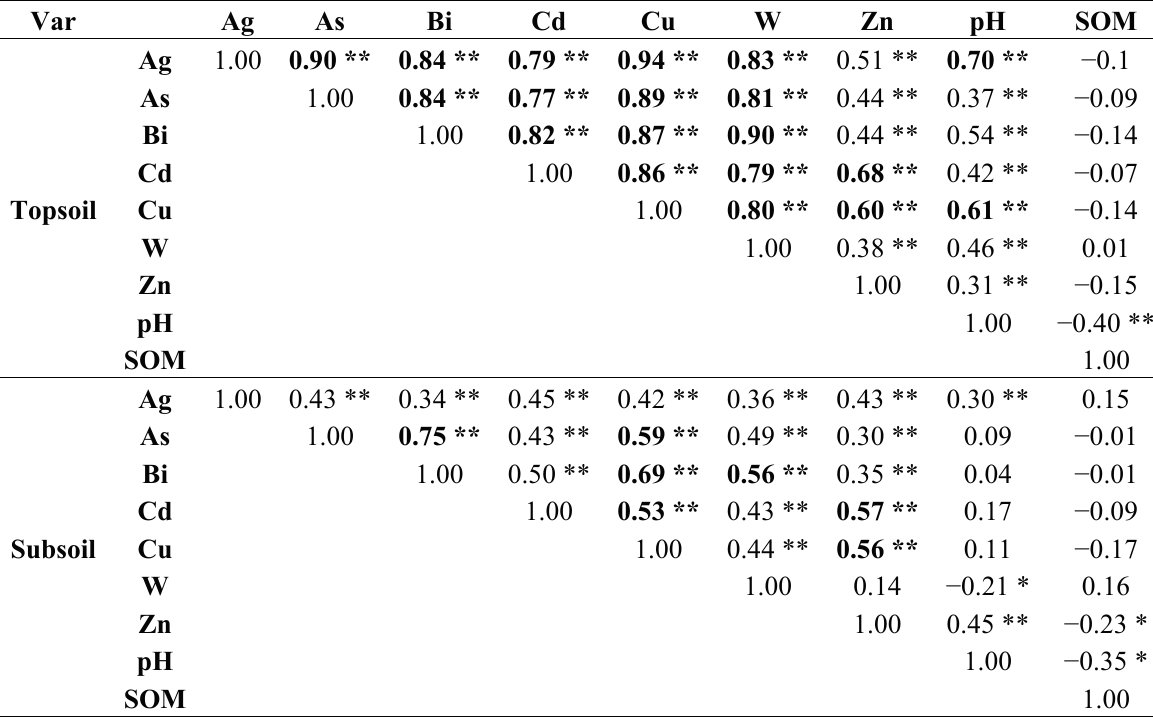
Table 5. Pearson’s linear product-moment correlation coefficients for Ag, As, Bi, Cd, Cu, W, Zn, pH and SOM in topsoil ( n = 122) and subsoil ( n = 116) samples. Var